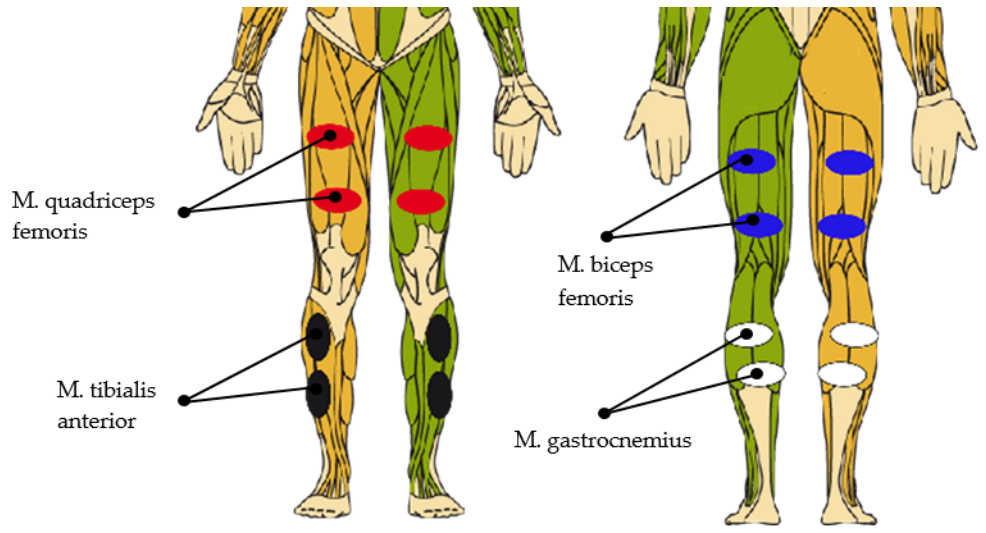
Figure 10. Stimulated muscles and electrode position .